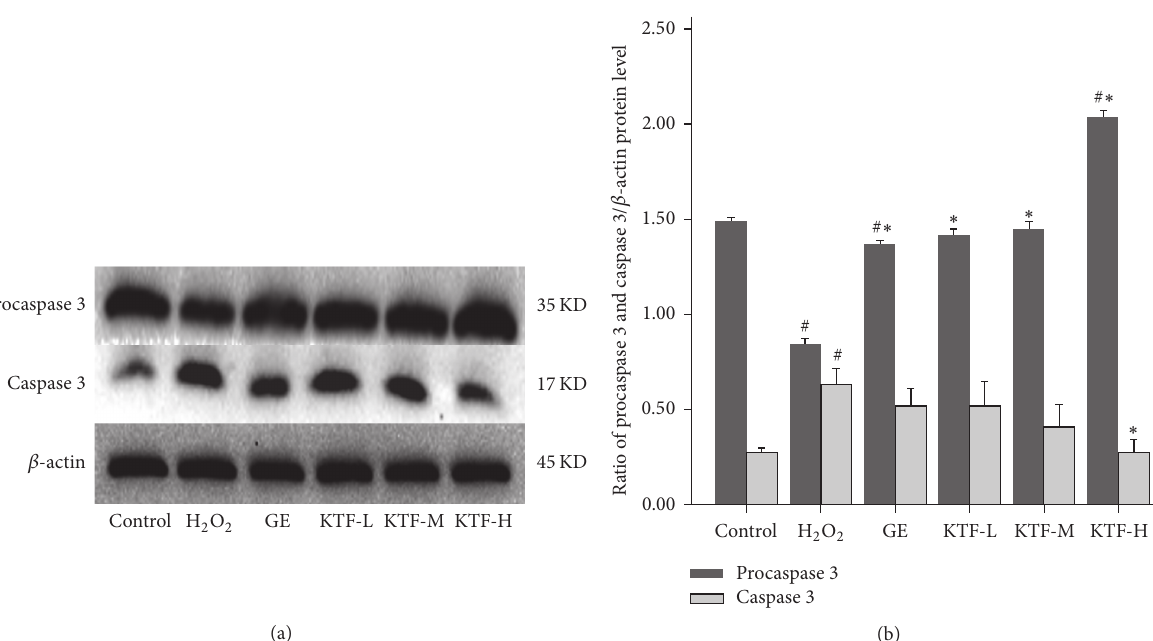
Figure 4: Effect of KTF on the protein expression of caspase 3 in H 2 O 2 -induced MES23.5 cells. (a) The protein expression of caspase 3 was determined with western blot and quantified in (b). Data are expressed as mean ± SD in three independent experiments. # 𝑃 < 0.05 compared to the control group. ∗ 𝑃 < 0.05 compared to the H 2 O 2 -treat group.